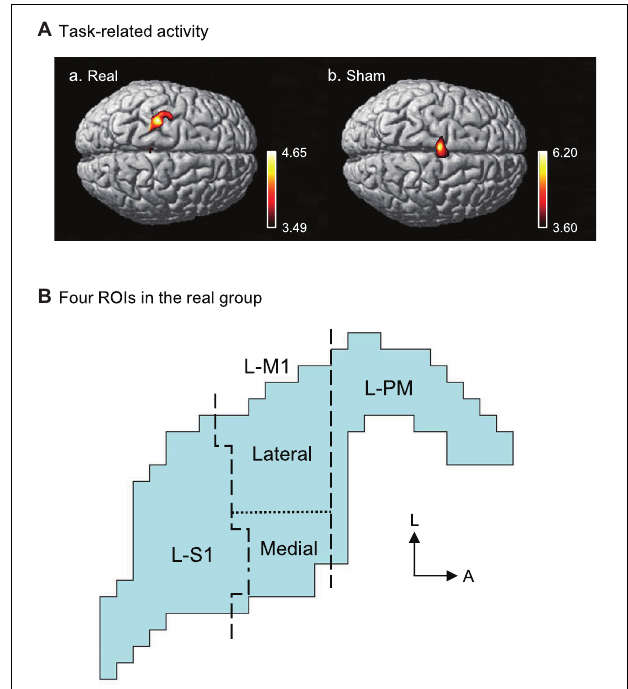
FIGURE 6 | Task-related cortical activation during the Purdue Pegboard test in the post-assessment. (A) NIRS-SPM T-statistic maps in the real (a) and sham (b) groups. Task-related cortical activation was observed in the somatosensory motor-related areas in the real group (a) , and the supplementary motor area (SMA) in the sham group. (B) Schematic illustration of the task-related cortical activation in the real group. The task-related activated areas were divided into 4 ROIs: left premotor area (L-PM), lateral left primary motor area (L-M1) (lateral L-M1, hand motor area), medial L-M1, and the left primary somatosensory area (L-S1). L, lateral; A,